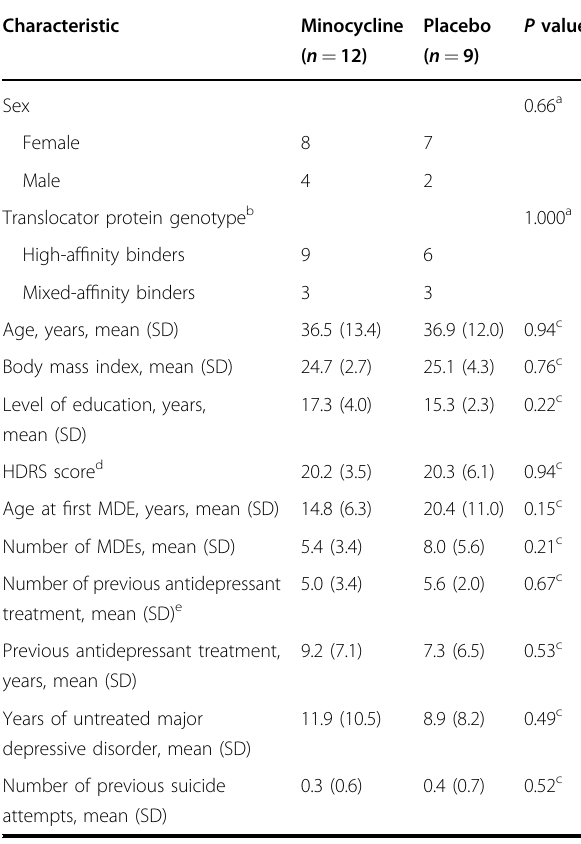
Table 1 Demographic characteristics of study